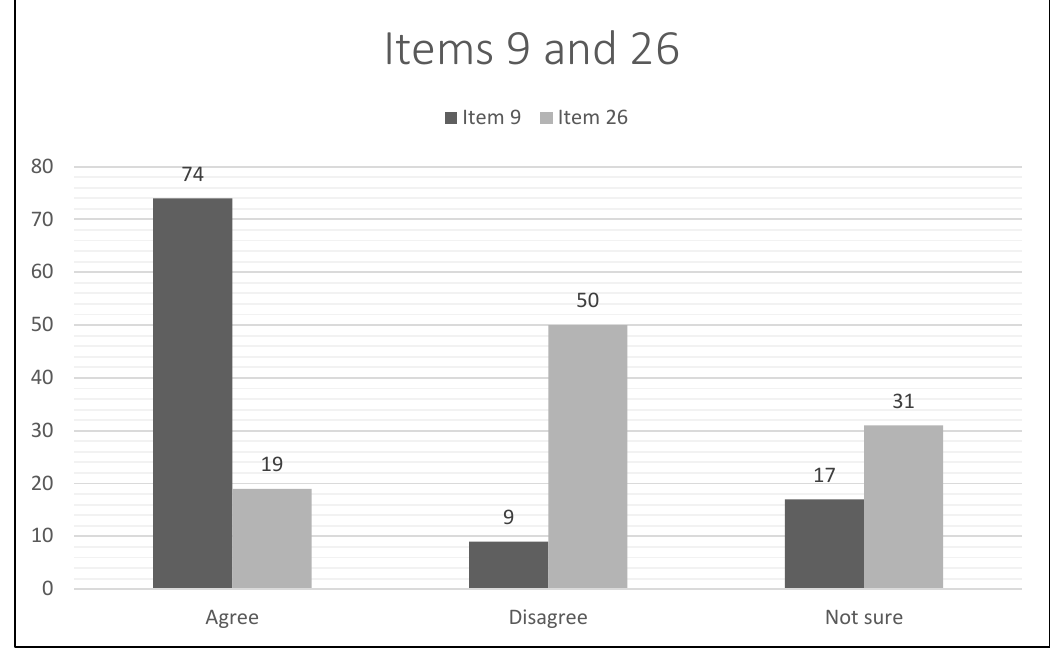
Figure 1. Comparison of responses to items 9 and 26.